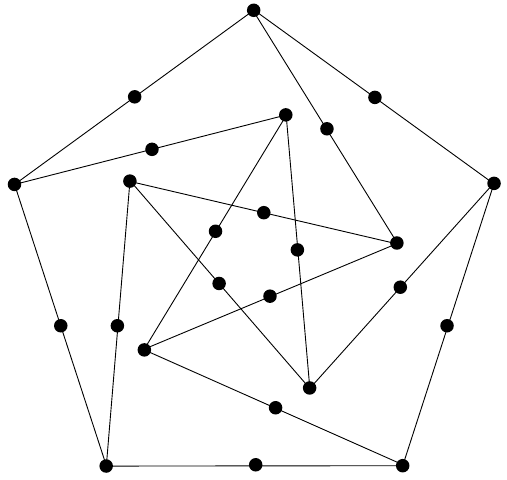
Figure 3. The minimum complete subdivision of the Petersen